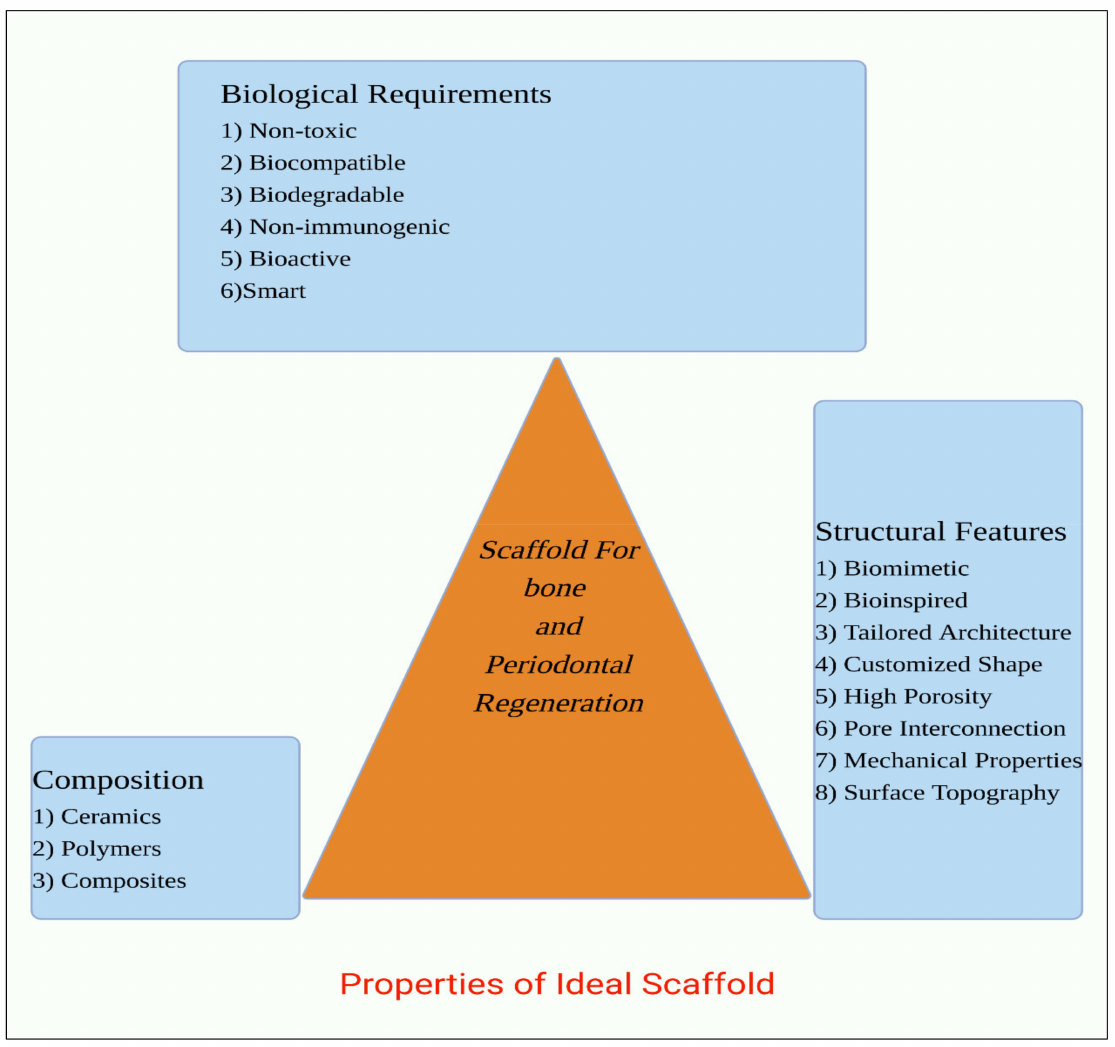
Figure 2. Features of ideal framework for tissue engineering